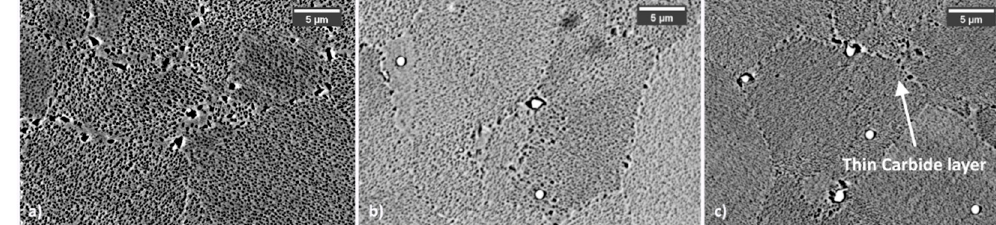
Figure 12. HT samples after solutioning ( a ), after first aging ( b ) and after second aging ( c